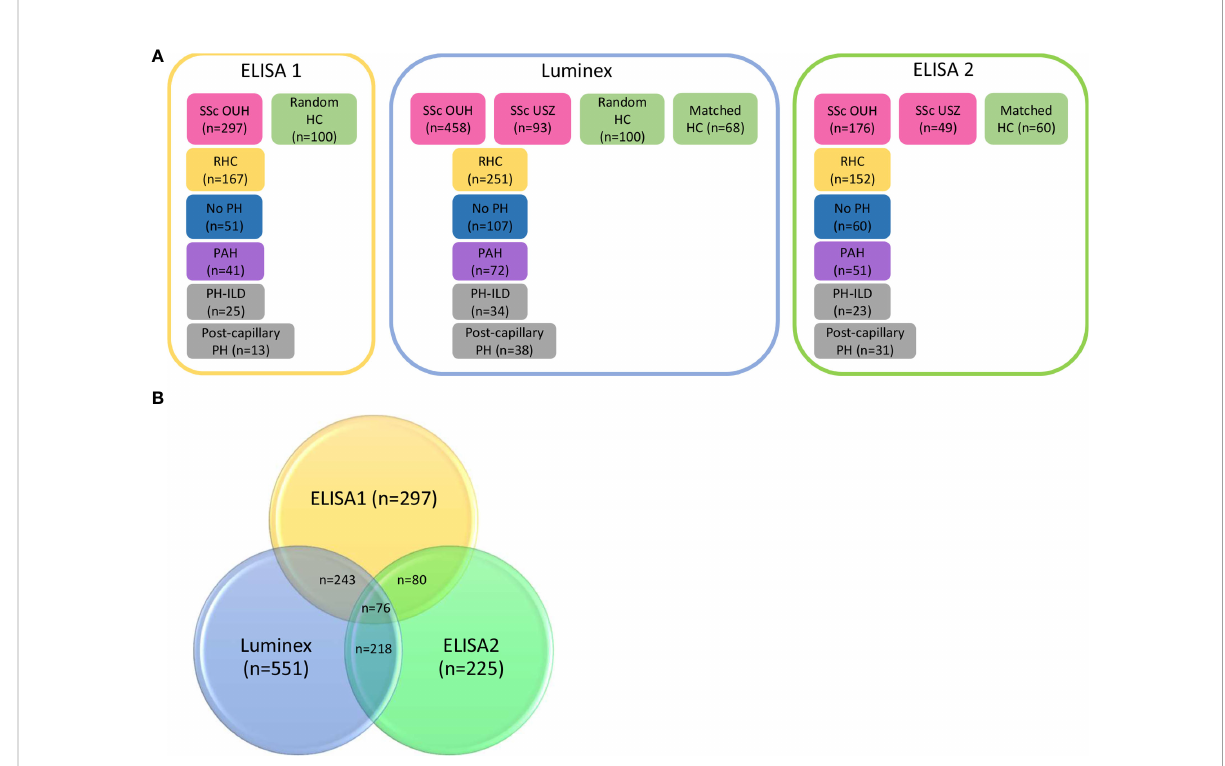
FIGURE 1 Schematic overview of the number of systemic sclerosis (SSc) patients included in ELISA 1, Luminex and ELISA 2. (A) In the previously published ELISA 1, 297 SSc patients and 100 random healthy controls were included. Of these 167 patients had undergone by RHC and 41 patients were diagnosed with PAH. In the Luminex analysis, serum samples from 458 SSc patients form Oslo University Hospital (OUH), 93 serum samples form SSc patients from Zurich University Hospital (USZ) and the random healthy controls were run, as well as 68 age and gender matched healthy controls. In total, 251/456 patients included in the Luminex analysis had undergone RHC and 72 were diagnosed with PAH. For the follow-up ELISA 2, 176 serum samples form OUS, 49 serum samples from USZ and 60 age and gender matched healthy controls were included. Of these patients, 152 had conducted RHC and 51 were diagnosed with PAH. (B) The samples overlapping in the three different runs were 243 samples between ELISA1 and Luminex, 80 in ELISA1 and ELISA2, and 218 in Luminex and ELISA 2. The number of samples overlapping in all three runs were 76